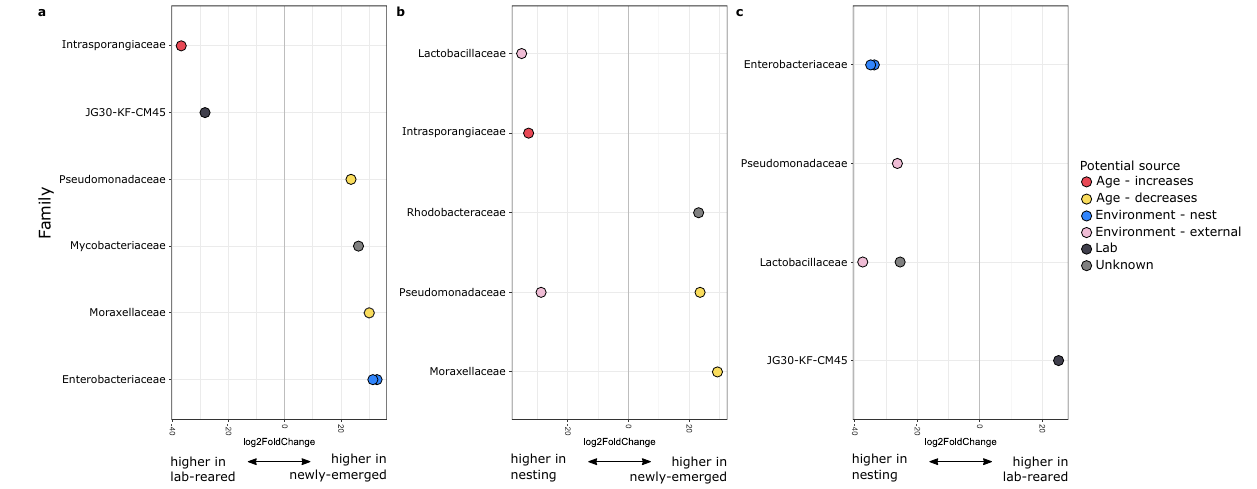
Figure 4. Differential abundance among adult females indicates potential sources of acquisition. Log 2 fold change in hindgut relative abundance between ( a ) lab-reared and newly-emerged females, ( b ) nesting and newly-emerged females, and ( c ) nesting and lab-reared females. Filled circles represent a single ASV, with family membership indicated on the y-axis and color indicating potential source of